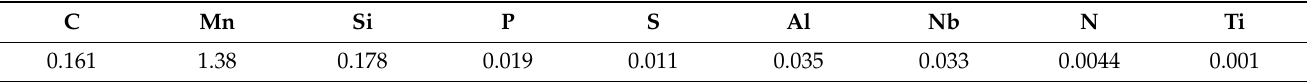
Table 5. Chemical composition of the selected HSLA steel in wt.%.